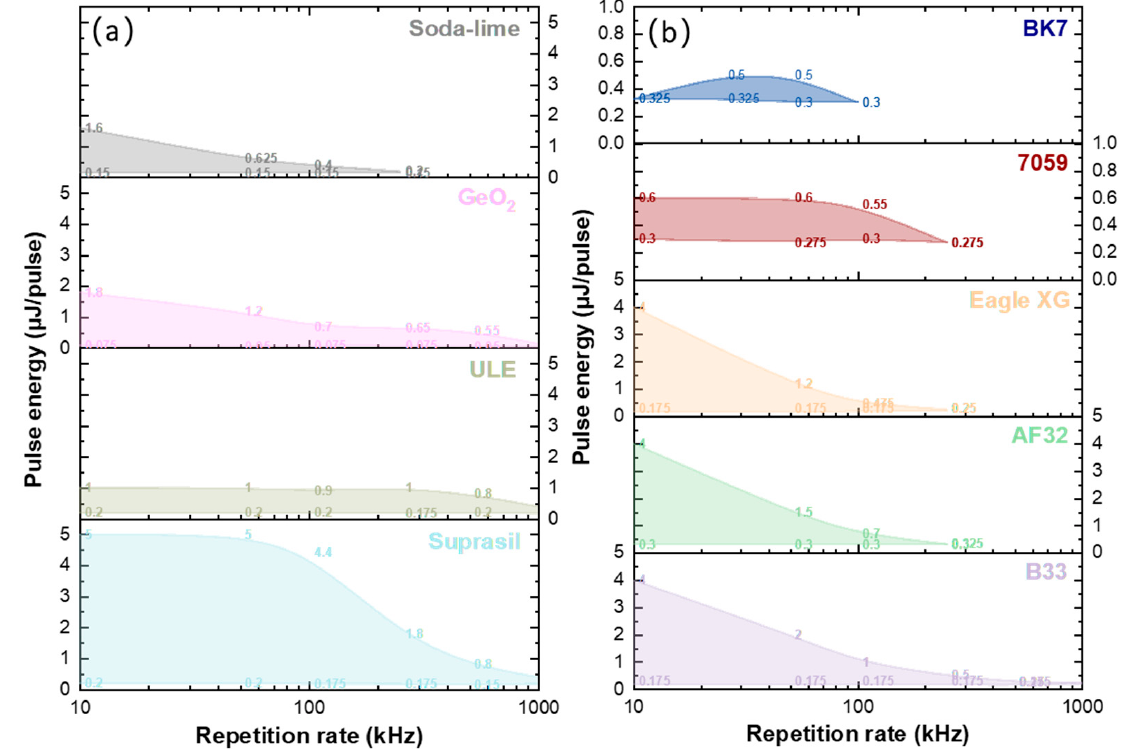
Figure 2. ( a ) Type II modification windows in the Suprasil, ULE, GeO 2 , and soda-lime glasses. ( b ) Type II modifications windows in B33, AF32, Eagle XG, 7059, and BK7 alumino-borosilicate glass. (Zoom × 5 in the figure of 7059 and BK7 samples). Experimental conditions: 1030 nm, 800 fs, 0.6 NA, pulses densities f / v = 10 3 pulse/µm (Suprasil, GeO 2 , AF32, B33, Eagle XG), f / v = 10 4 pulse/µm (soda-lime), f / v = 10 5 pulse/µm (7059 and BK7), Xx writing configuration.